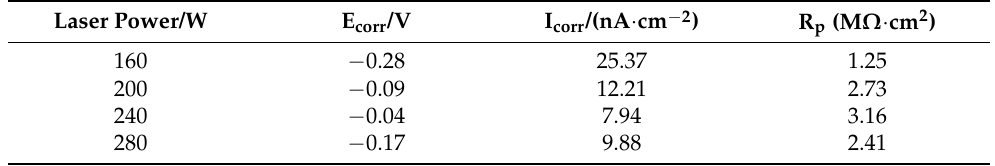
Figure 6. Polarization curves of Ti6Al4V alloy at laser power of ( a ) 160 W and ( b ) 280 W. Table 1. Corrosion potential and current density of Ti6Al4V alloy in SBF at scanning rate of 1200 mm/s.